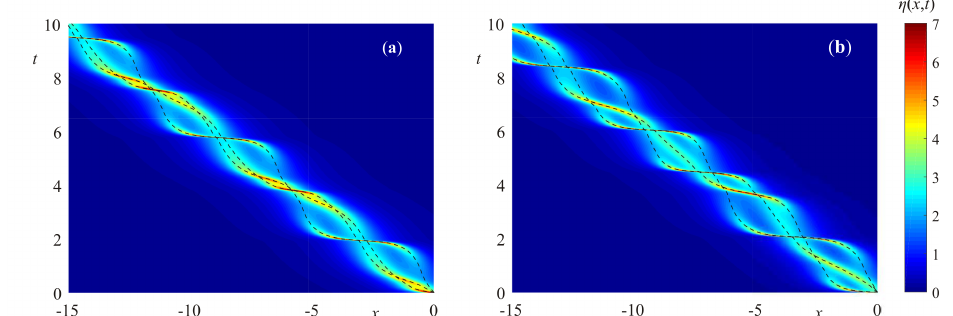
Figure 2. The evolution of the interface is shown for the different initial conditions: ( a , b ) correspond to Figure 1b,d, respectively. Black dashed lines correspond to the pole positions at real x -axis.